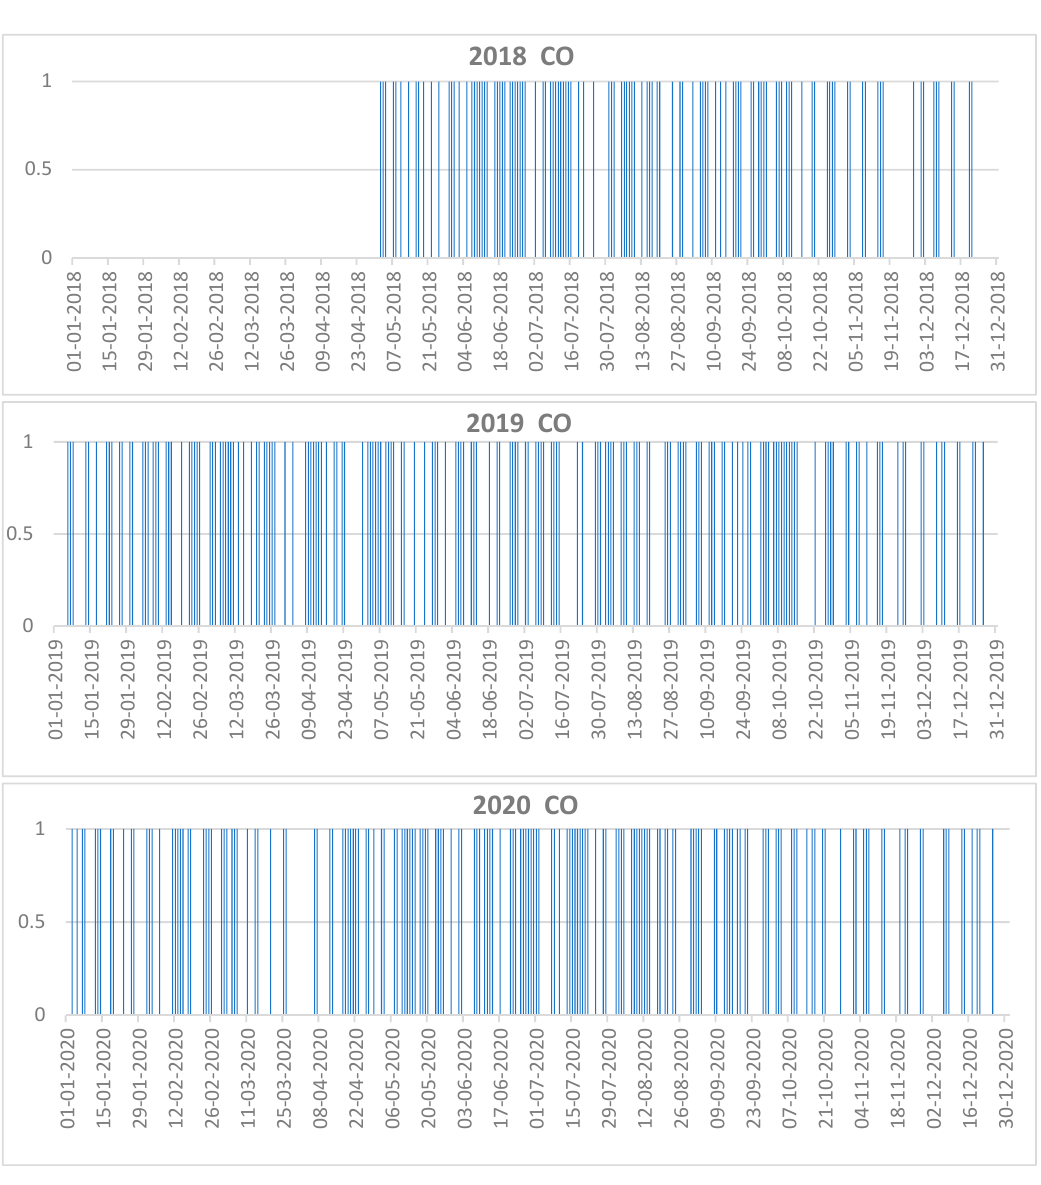
Figure 7. Days with NO 2 emissions of more than 3 σ above the background concentration, Kemerovo region, for each year from 2018 to 2022 separately.